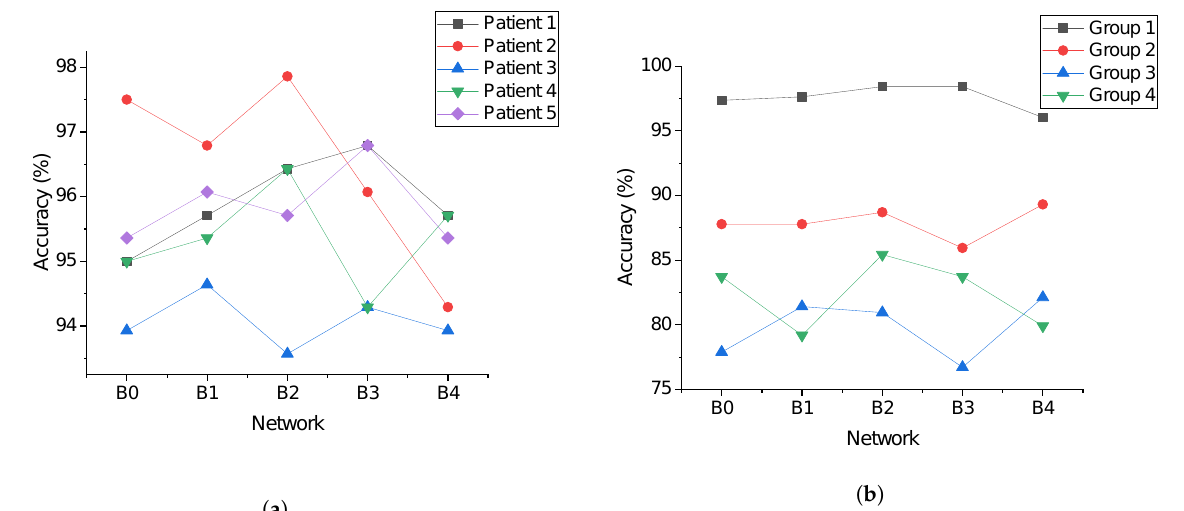
Figure 8. Accuracy when scaling the network. Scaling of the depth, width, and resolution of the network. ( a ) Data from Table 5, the result of Experiment 2 when transfer learning was used. ( b ) Data from Table 12, the result of Experiment